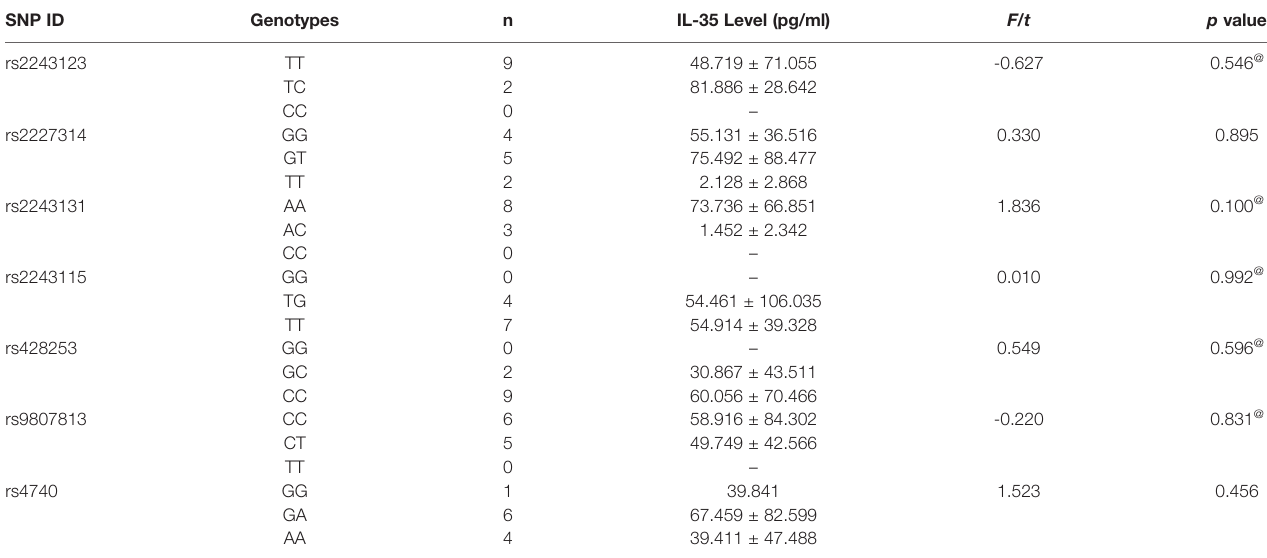
TABLE 7 | Associations of serum IL-35 levels with IL-35 genotypes in BD patients.